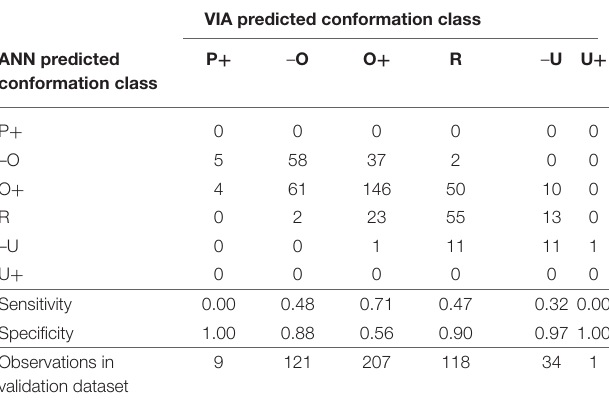
TABLE 5 | Confusion matrix for the conformation grade classification artificial neural network and the sensitivity and specificity of the model to each grade. VIA predicted conformation